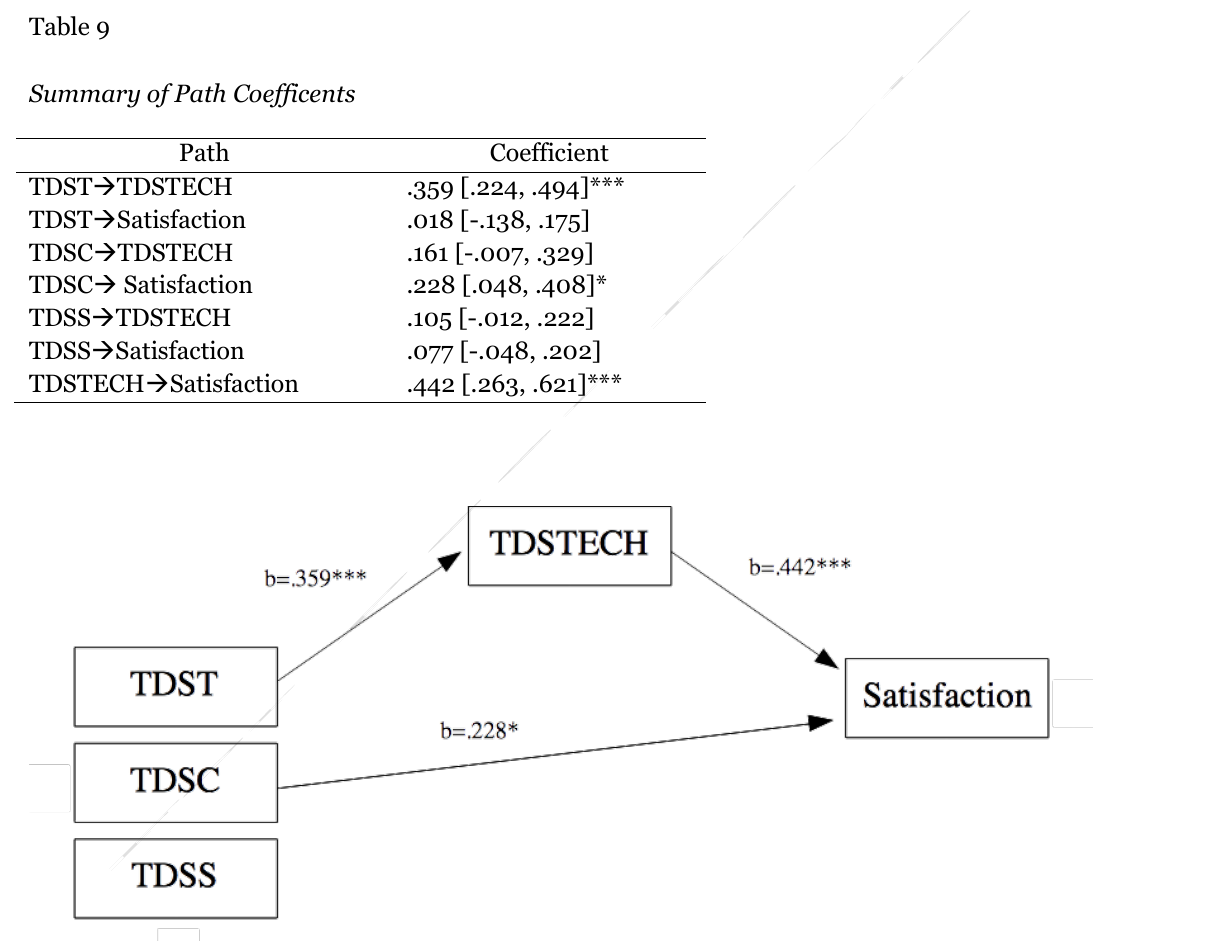
Summary of Path Coefficents